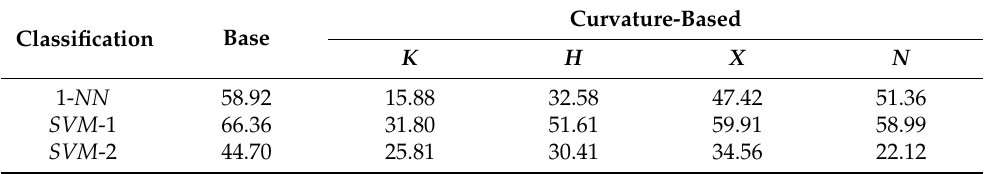
Table 3. The accuracy (%) results from the EYB dataset for the eye images and the extracted curvatures.